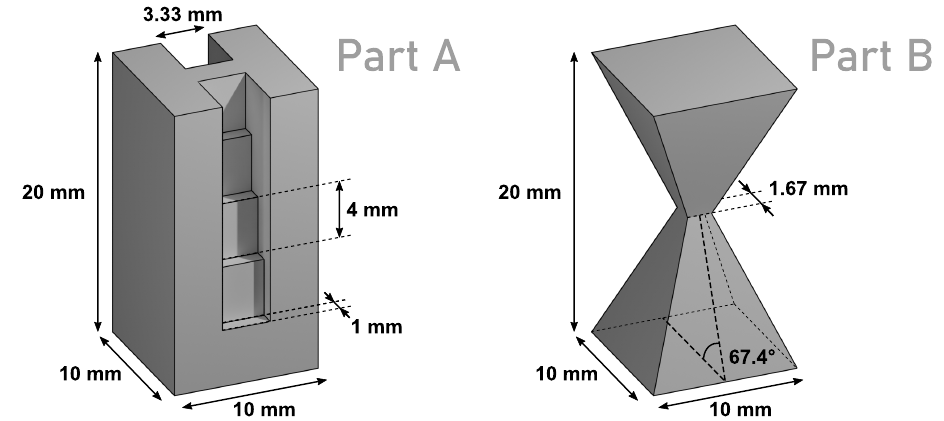
Figure 1. Geometry and dimensions of part A and part